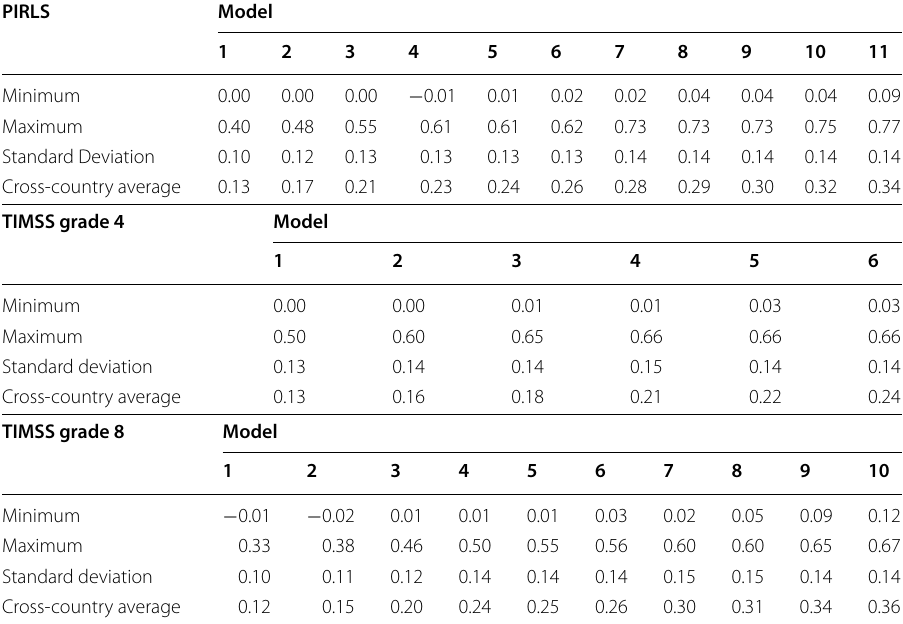
Table 6 Descriptive statistics of R 2 (explained variance of achievement score) across coun‑ tries by model and study PIRLS